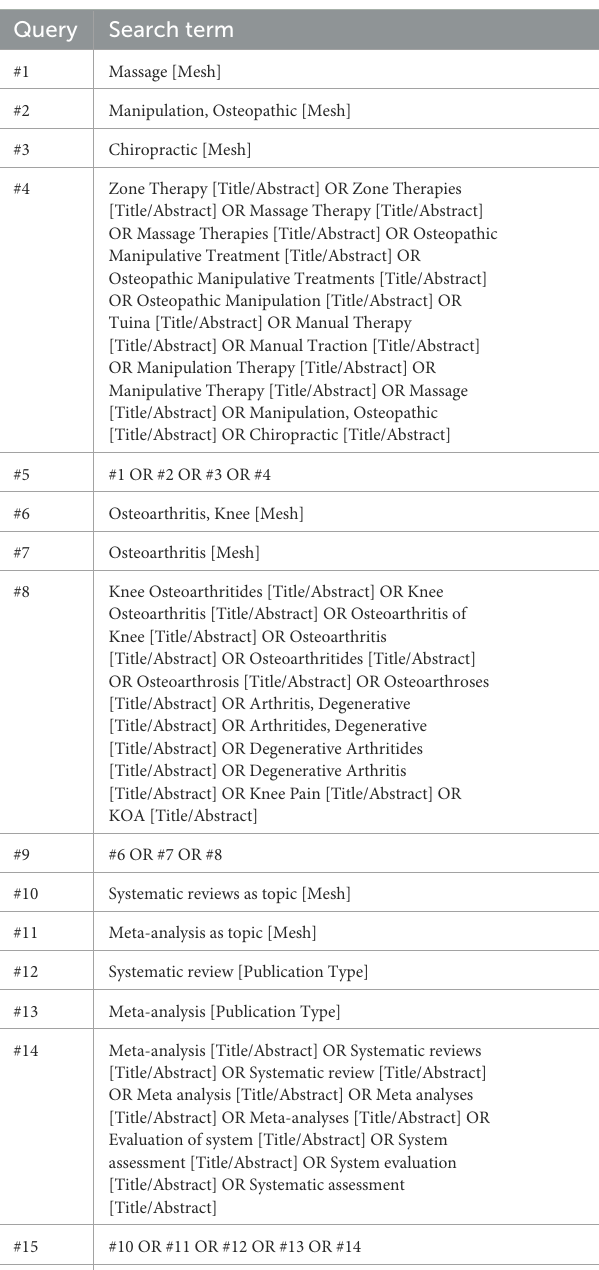
TABLE 1 The search strategy for